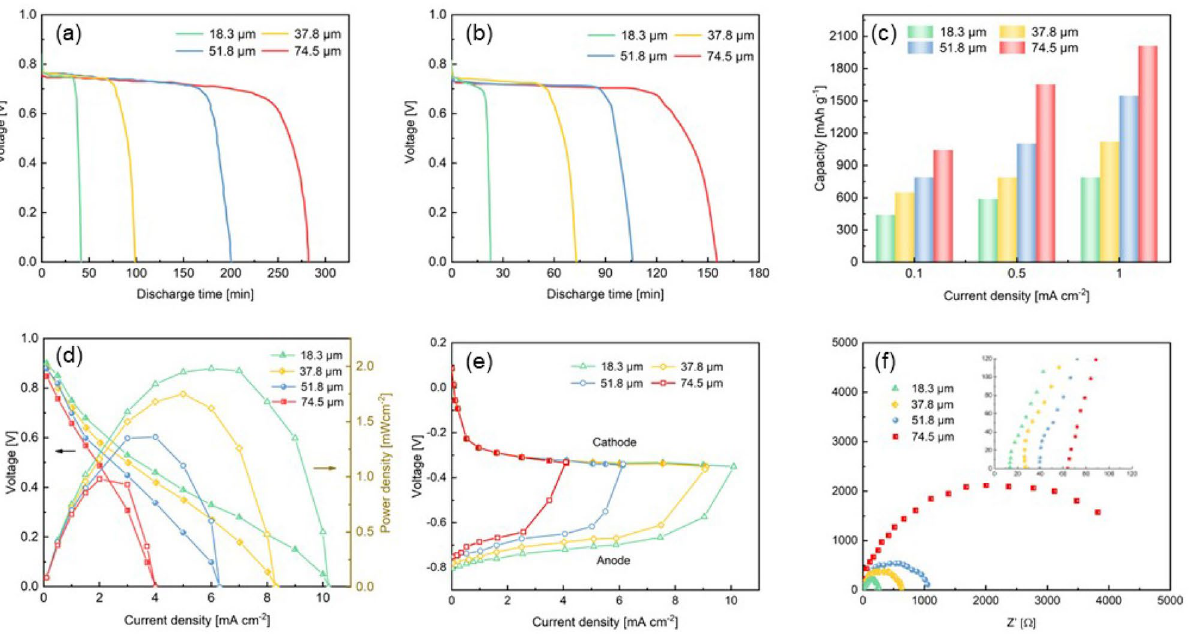
Figure 4. The discharge profiles of the Al–air battery at ( a ) 0.1 and ( b ) 0.5 mA cm −2 . ( c ) Specific capacity of the Al–air batteries with electrolytes of different thicknesses. ( d ) The polarization curves and power-density profiles of the Al–air batteries. ( e ) Single electrode polarization. ( f ) EIS analysis of the Al–air electrolyte of different thicknesses. The specific capacity of the battery increases as the thickness increases of the electrolyte. When the electrolyte thickness is 74.5 μm, the specific capacity could reach 2011 mAh g −1 at the cur- rent density of 1 mA cm -2 . Under the same discharge current density, the specific capacity obtained in this study is higher than that of the traditional Al–air battery with alkaline electrolyte 32,33 . This is mainly due to the serious self-corrosion of the Al anode under the condition of alkaline electrolyte. From the perspective of anode utiliza- tion, Al electrode under neutral electrolyte conditions are mainly mechanical loss rather than chemical loss 30 . Figure 4d comparing the battery performance with different thicknesses of electrolyte. The increase in elec- trolyte thickness seriously affects the performance of the battery. The thickness of the electrolyte increases from 18.3 to 74.5 μm, the peak power density decreases from 1.98 to 0.98 mW cm -2 , and the maximum current density decreases from 10.2 to 4 mA cm -2 . Wang et al 31 . prepared a 2 mm thick ethanol gel electrolyte and applied it to Al–air battery, and the obtained power density of the battery is very close to the result of this study. Although the power density of the battery using this ultrathin NaCl electrolyte is lower than that with traditional liquid alkaline electrolytes 34,35 , it is sufficient for wearable flexible electronic devices such as medical diagnostic assays, biosensors and RFID tags, which only need to consume milliwatts or microwatts of power 36–38 . As can be seen in Fig. 4e, the cathode performance kept identical and straight, while there is a significant difference and mass transport loss at the anode side as the electrolyte thickness increases. Figure 4f shows that the battery ohmic resistance is greatly reduced from 63 Ω for 74.5 μm electrolyte to 12 Ω for 18.3 μm electrolyte. In the research of Yang et al. 39,40 , it has also been confirmed that the performance of the battery is affected by the thickness of the electrolyte. As the distance between the two electrodes decreases, the ion diffusion efficiency in the electrolyte increases, the internal resistance of the battery decreases accordingly, and the battery performance improves. Combining the specific capacity of the anode and the battery performance, it can be seen that for the ultrathin electrolyte, the thickness reduction of the electrolyte can effectively improve the performance of the Al–air bat- tery, but at the expense of the specific capacity of the aluminum electrode. In addition to the thickness, the concentration of Cl - ions in the ultrathin electrolyte is also an important fac- tor. Taking a 37.8 μm thick solid electrolyte as an example, Fig. 5a,b show the discharge curves of Al–air batteries with ultrathin electrolytes of different NaCl content at the current density of 0.1 and 0.5 mA cm -2 . It can be seen from the figure that as the NaCl content increases, the discharge platform voltage increases, the stability is bet- ter, and the discharge time is prolonged. Figure 5c shows the relationship between the battery specific capacity and the concentration of NaCl in electrolyte. Increasing the NaCl content can significantly increase the specific capacity of the battery. A battery with an electrolyte containing 2.1 mol NaCl could obtain a specific capacity of 2105 mAh g -1 , which is comparable to an Al–air battery with a 1 mm thick ethanol gel electrolyte 31 , and higher than a magnesium-air battery of similar electrolyte composition 41 . This may be due to the fact that, compared with traditional preparation methods, the distribution of the components in the electrolyte prepared by aerosol jet printing is extremely uniform, and the passage of Cl - ions is more convenient. As shown in Fig. 5d, the battery performance is gradually improved as the NaCl content increased. When the NaCl content increases to 1.8 mol, the power density of the battery reaches 5.33 mWcm -2 . Continue to increase the NaCl content, the performance of the battery will decrease instead. This is consistent with the influence of NaCl content on conductivity as